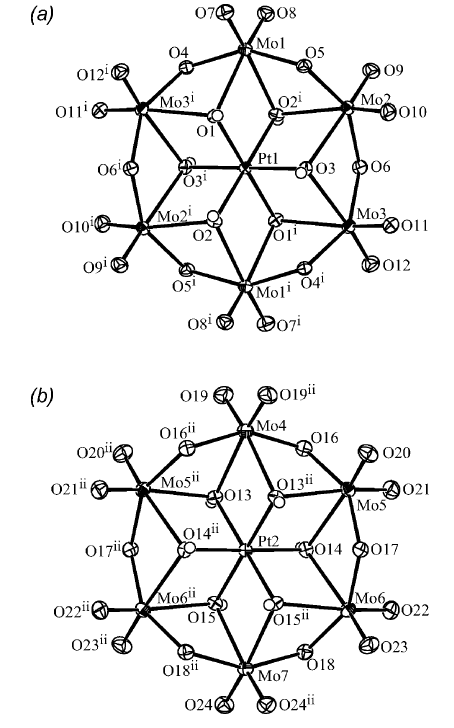
Table 2 Hydrogen-bond geometry (A˚ , (cid:5)